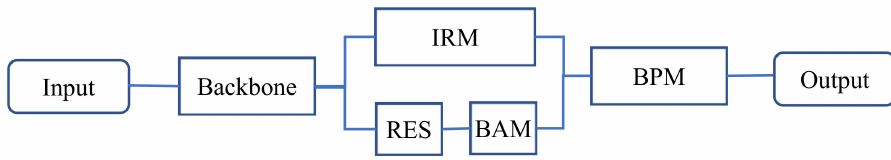
Figure 2. Complete flowchart of